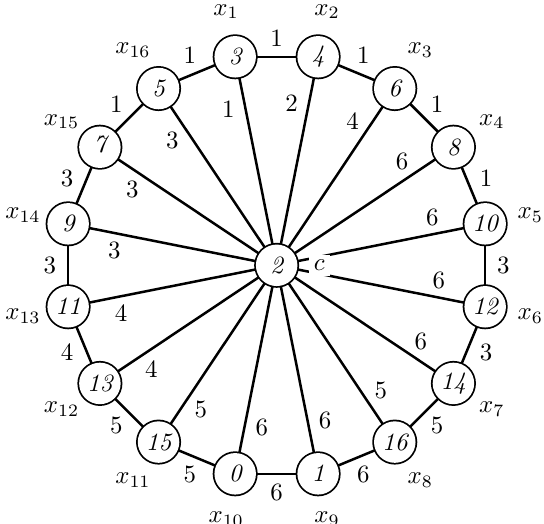
Figure 4. A modular irregular 6-labeling of W 16